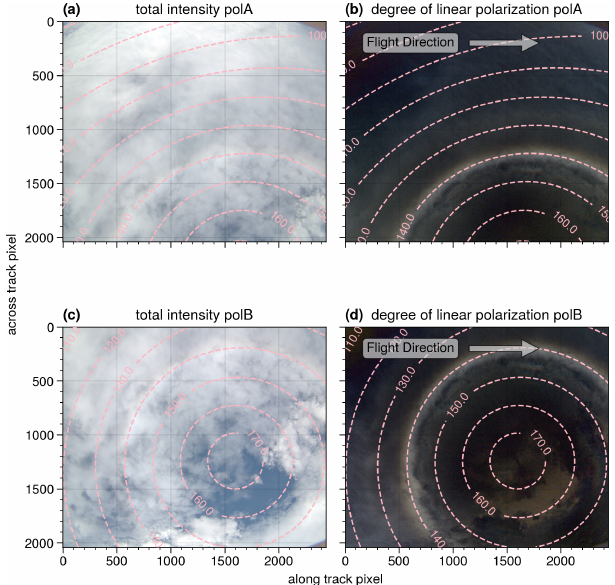
Figure 2. Example of measurements of both polarization cameras (2 February 2020, 16:47:45.07UTC): (a, b) measurements from the first polarization camera (polA), which looks slightly to the left in the flight direction; (c, d) measurements from the second polariza- tion camera (polB), which looks slightly to the right in the flight direction. The field of view of the two cameras overlaps. Panels (a) and (c) show the total intensity, and panels (b) and (d) show the DOLP. The dashed lines indicate lines of constant scattering angles in degrees. The primary bow of the cloudbow is visible in the DOLP as a bright ring at a scattering angle of about 140 ◦